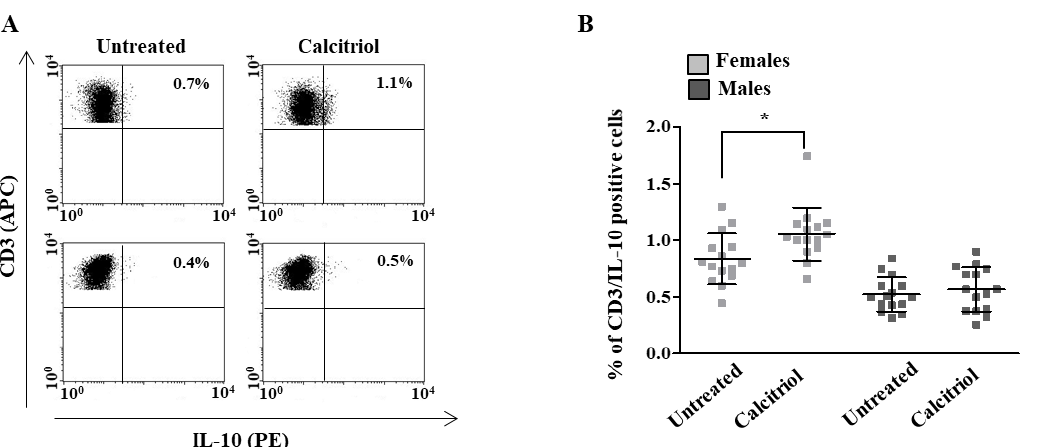
Figure 3. Calcitriol effects on anti-inflammatory cytokine production in peripheral blood T lymphocytes from female and male healthy donors. IL-10 expression was analyzed in 15 female and 15 male healthy subjects by flow cytometry after 48 h of culture with calcitriol and stimulation with phytohemagglutinin (PHA) in the presence of brefeldin A for the last 16 h of culture, as detailed in Section 4. ( A ) Results from representative female (upper panels) and male (lower panels) healthy donors are shown. ( B ) Data are also reported as mean ± SD. * p < 0.05 versus untreated cells.